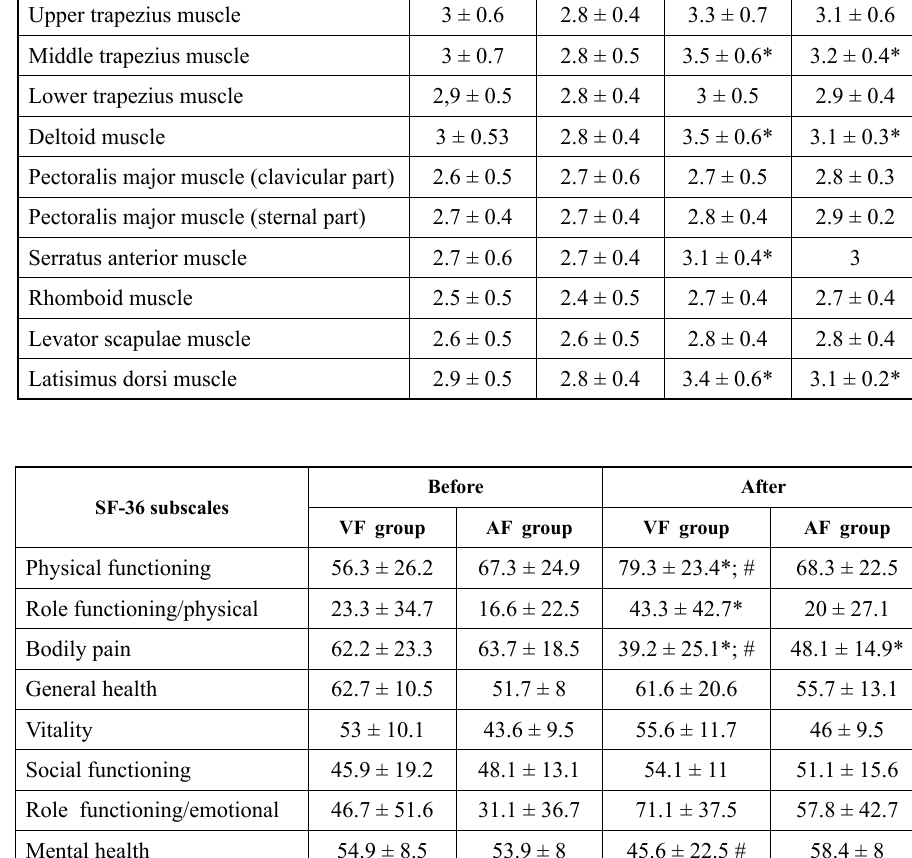
Table 2. Results of func - tional muscle strength evaluation before and after the study